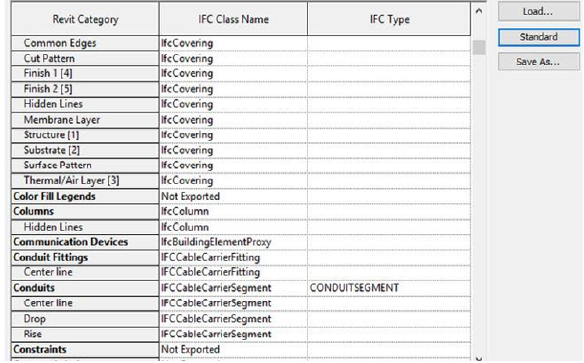
Figure 17. An example of the IFC exporting setting.